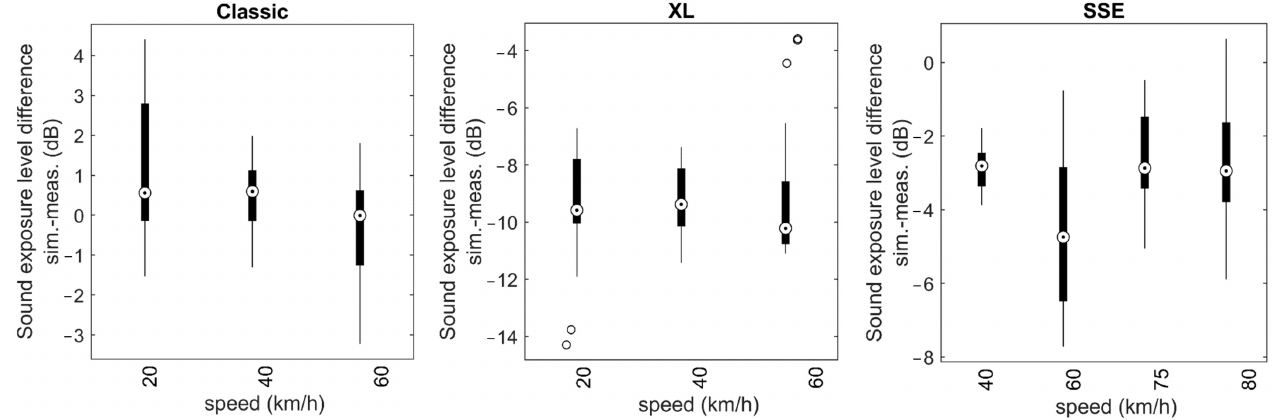
Figure 7. Box–whisker plots of the difference of simulated vs. measured sound exposure levels for the three multicopters under evaluation and different speeds.